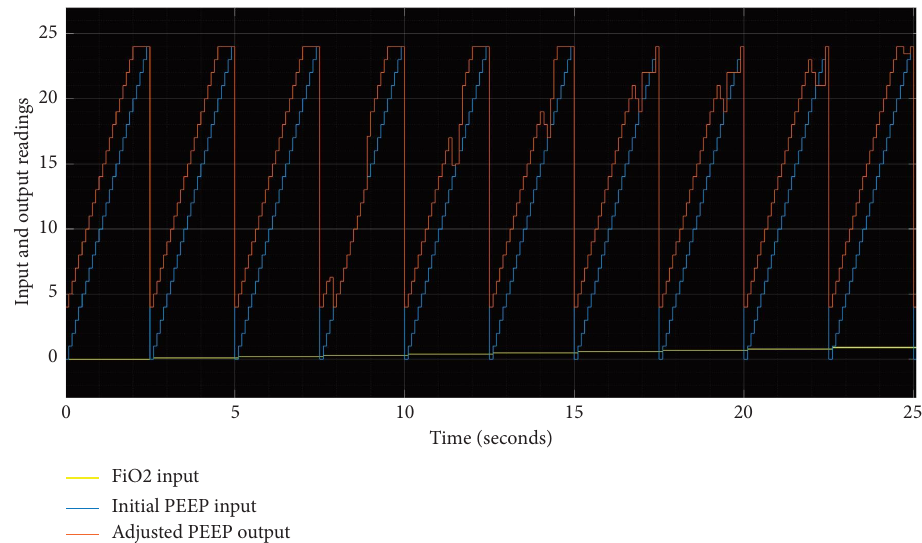
Figure 15: FiO 2 input, non-fuzzifed initial high PEEP input, and fuzzifed adjusted PEEP output